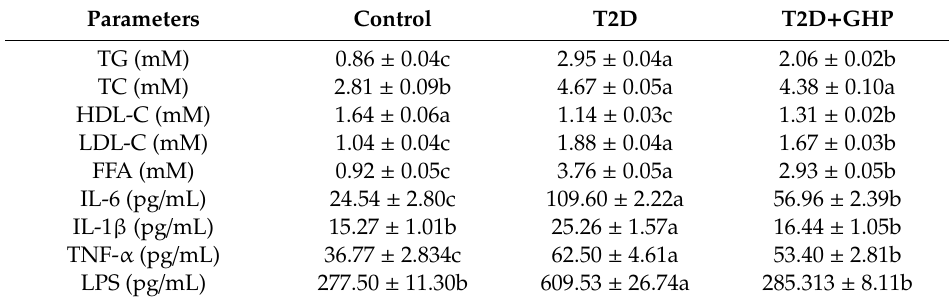
Table 1. E ff ects of GHP supplementation on the serum lipid and inflammation in T2D mice. Table 1. Effects of GHP supplementation on the serum lipid and inflammation in T2D mice. Parameters